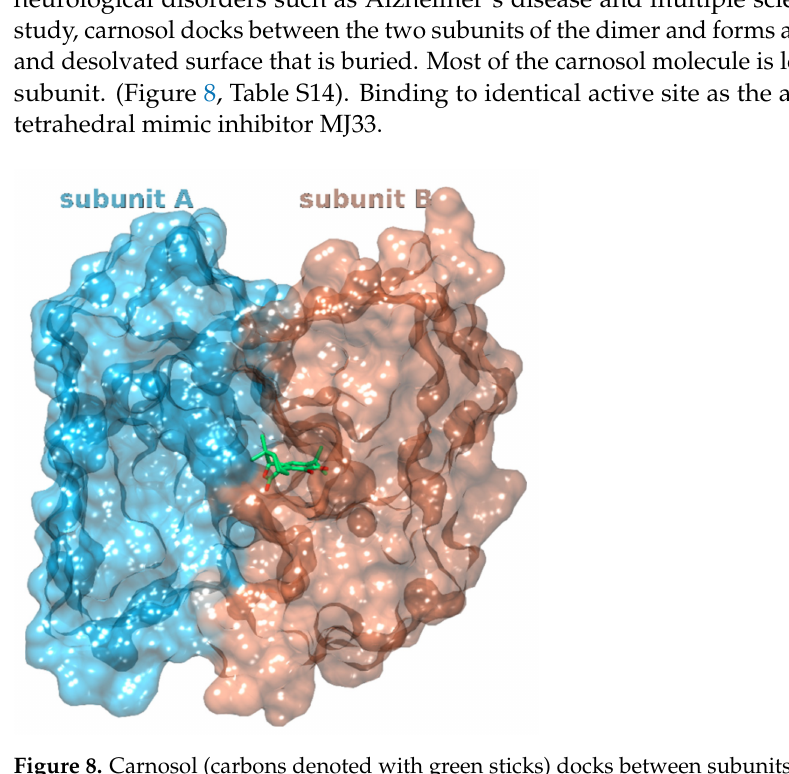
Figure 8. Carnosol (carbons denoted with green sticks) docks between subunits A (blue surface) and B (orange surface) of the phospholipase